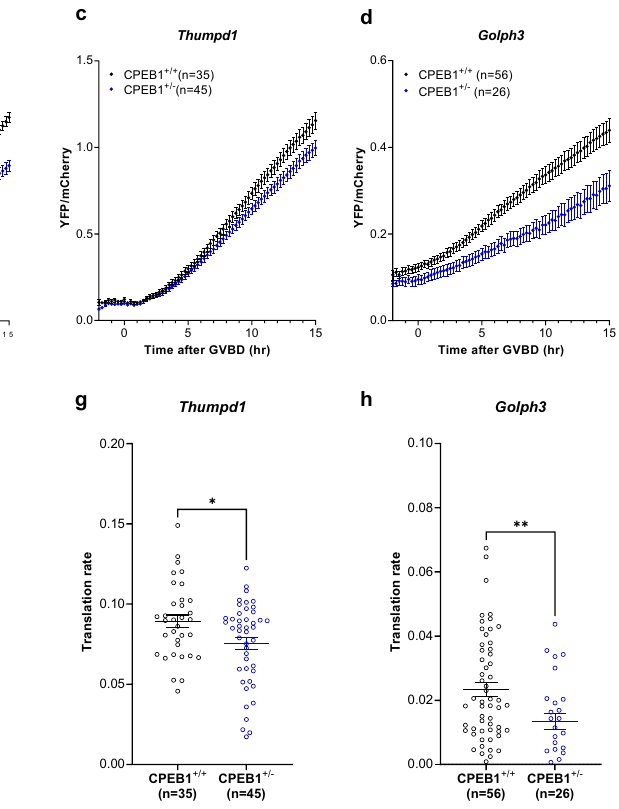
eachoocytewasplotteddependingonthetimeofGVBD. e – h Translationratewas calculatedfor eachoocyte bylinearregression ofthe reporter data between5and 10h ( a , d ) or between 7 and 12h after GVBD ( b , c ). Experiments were repeated three times and the data are shown as the mean ± SEM. Two-tailed unpaired Student ’ s t tests were used to evaluate statistical signi fi cance, ns not signi fi